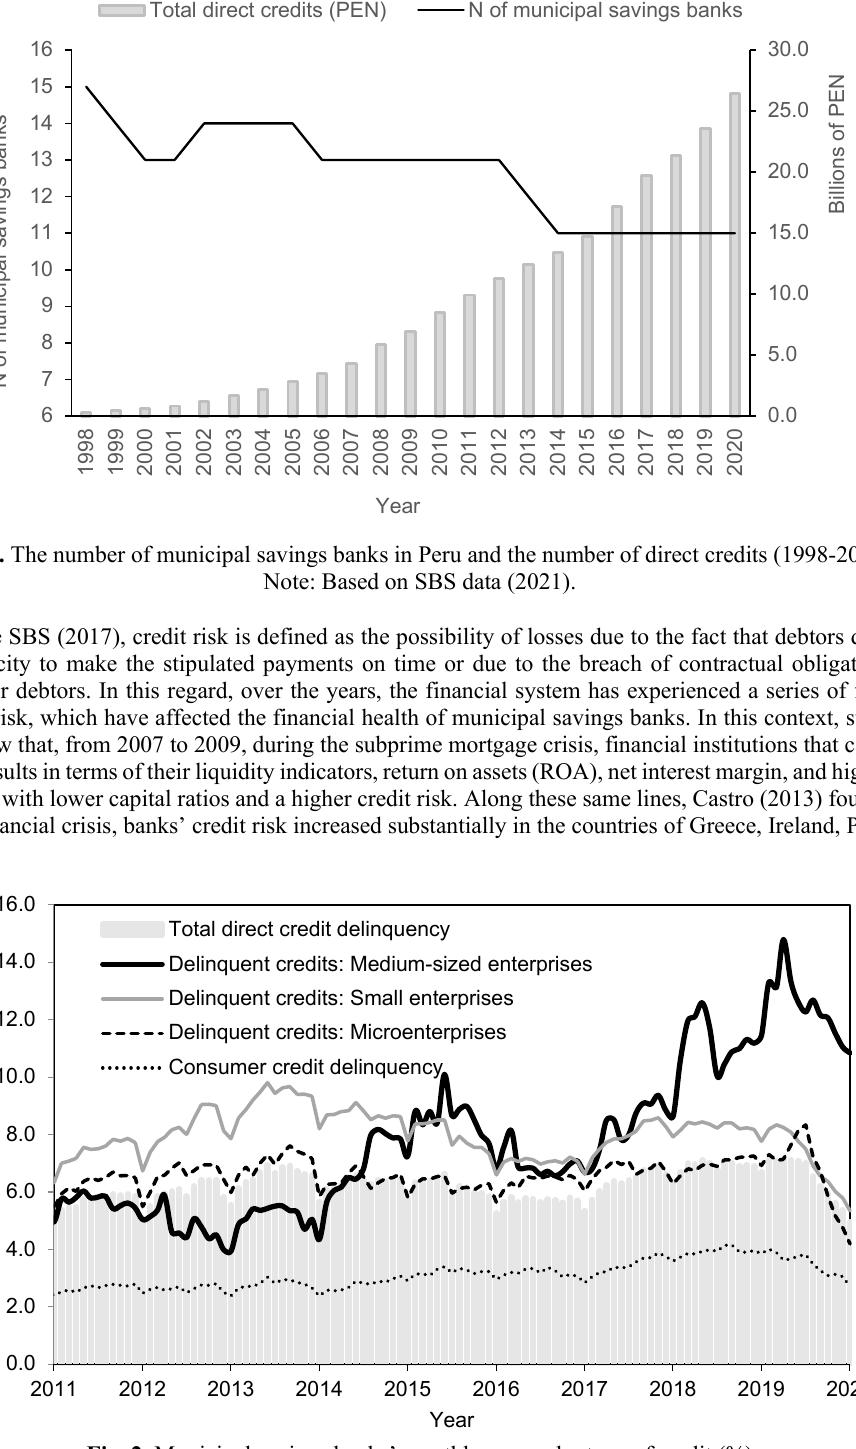
Fig. 2. Municipal savings banks’ monthly arrears by type of credit (%) Note: Based on SBS data